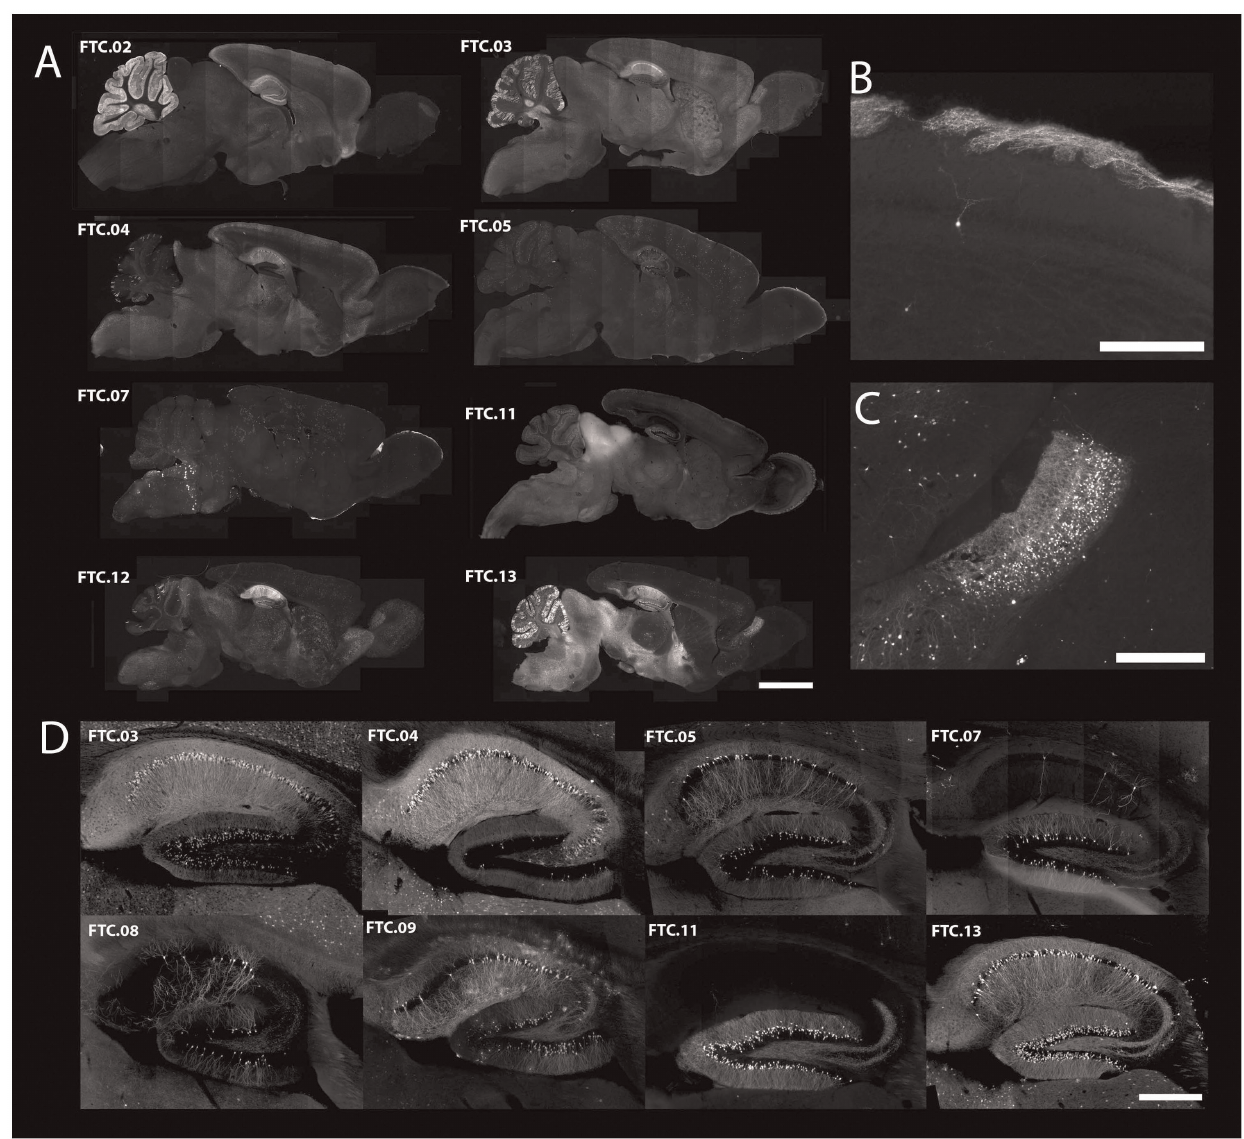
Figure 4. Labeling of subsets of neurons in thy1mp-cre lines. (A) Sagittal sections of mice carrying a single copy of the thy1mp-cre transgene (lines named FTC.01-FTC.13). A large variety of subsets of neurons were labeled in eight independent mouse lines shown here (bar=2.5mm). (B) Labeling of olfactory receptor neurons (FTC.07) (bar=250 um). (C) Labeling of granule cell neurons in the accessory olfactory bulb (FTC.13) (bar=500um). (D) Sagittal sections of the dorsal hippocampal formation of eight different thy1mp-cre lines reveal recombination restricted to subregions of the hippocampus (CA1, CA3 or dentate gyrus) (bar=500 um).